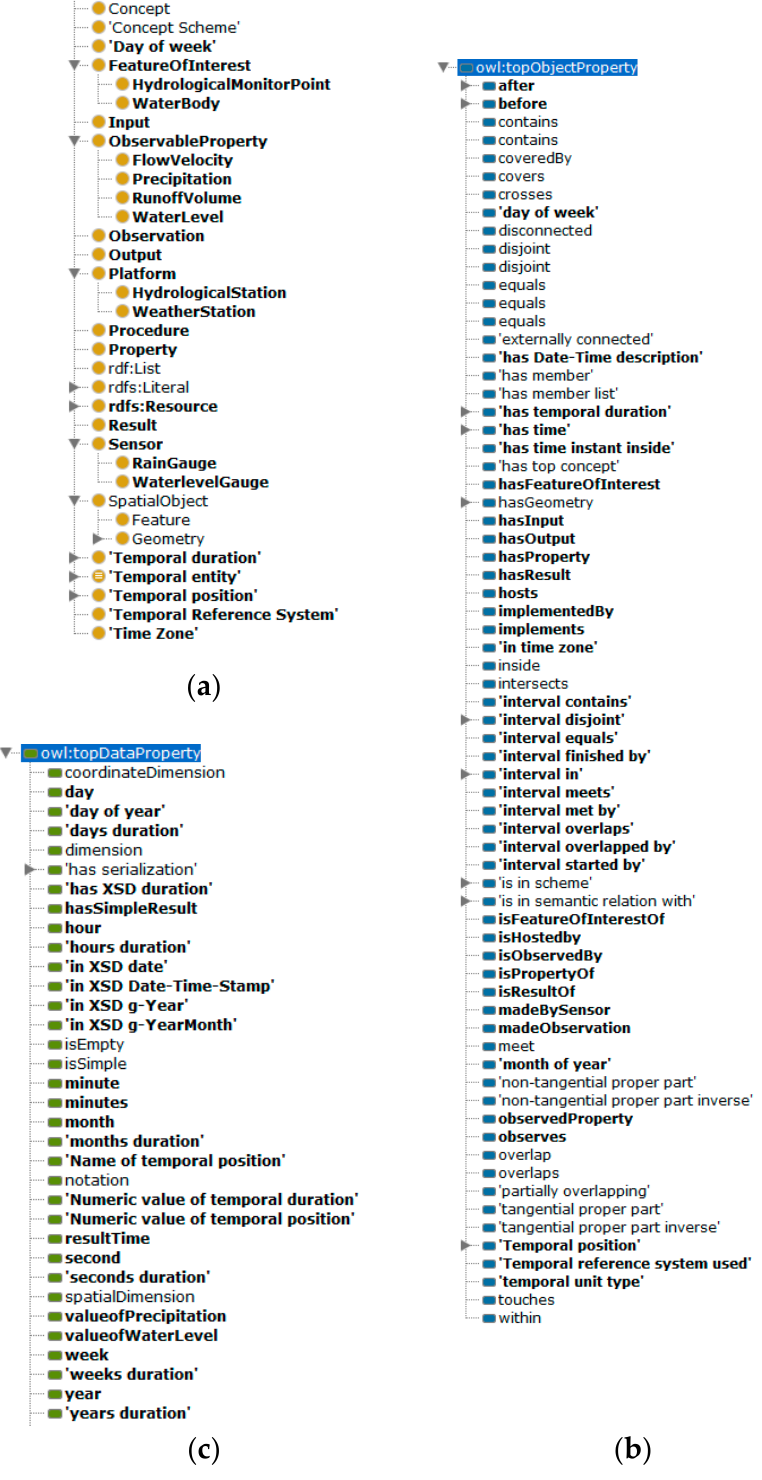
Figure 3. Class hierarchy, object properties, and individual definitions of the flood ontology in Protégé. ( a ) Class hierarchy of the proposed ontology. ( b ) Object properties of the proposed ontology. ( c ) Data properties of the proposed ontology.